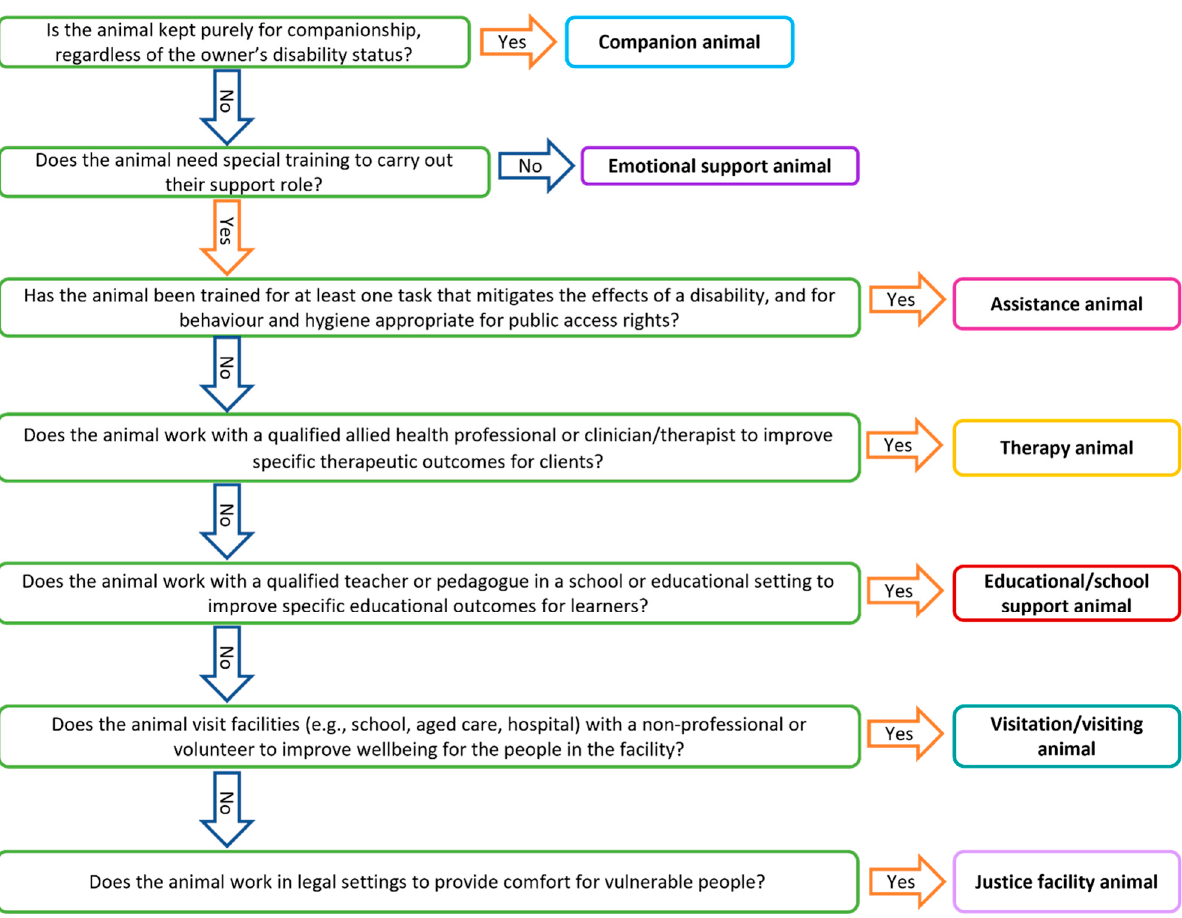
Figure 1. Flow diagram of relationships between various animal roles.